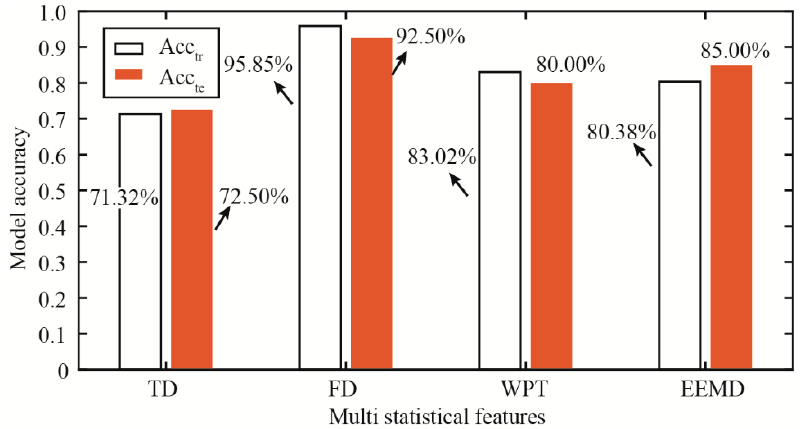
Figure 11. Model performance obtained from multiple statistical